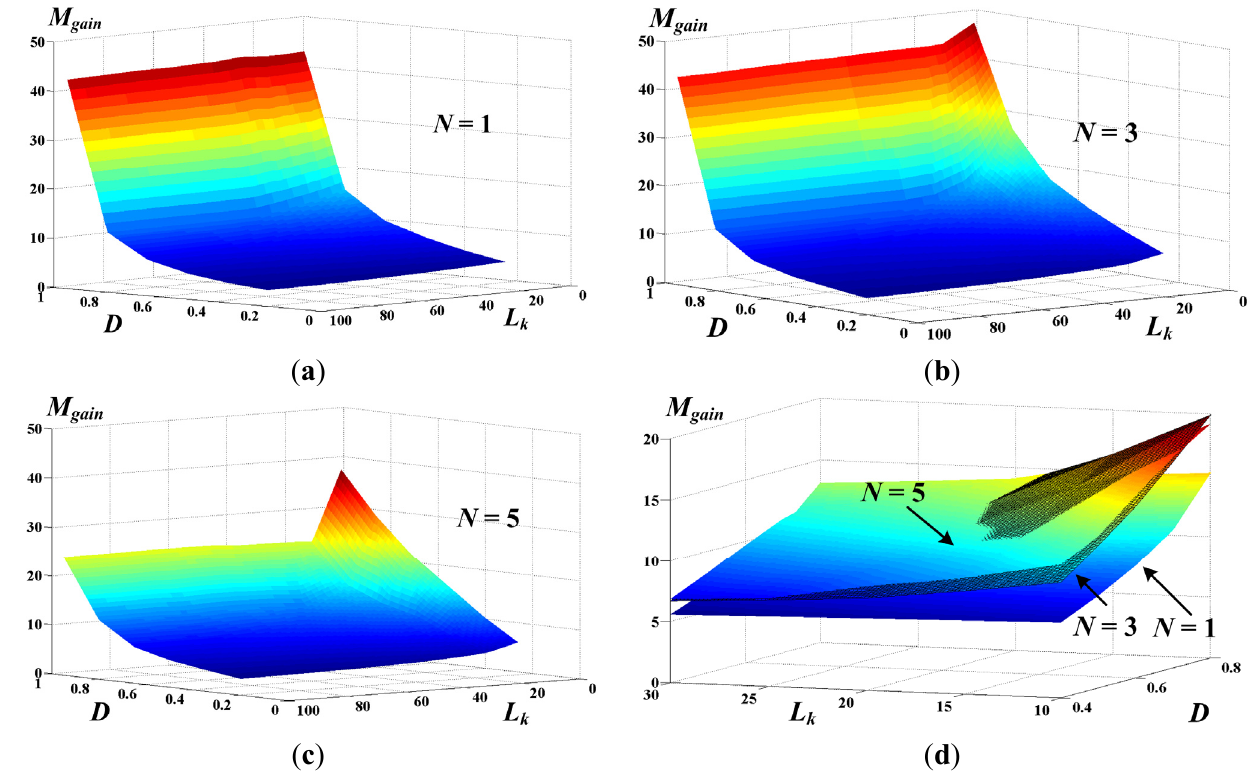
Figure 13. Relationship of M gain and N , D , L k . ( a ) case of N = 1; ( b ) case of N = 3; ( c ) case of N = 5; ( d ) case of chosen